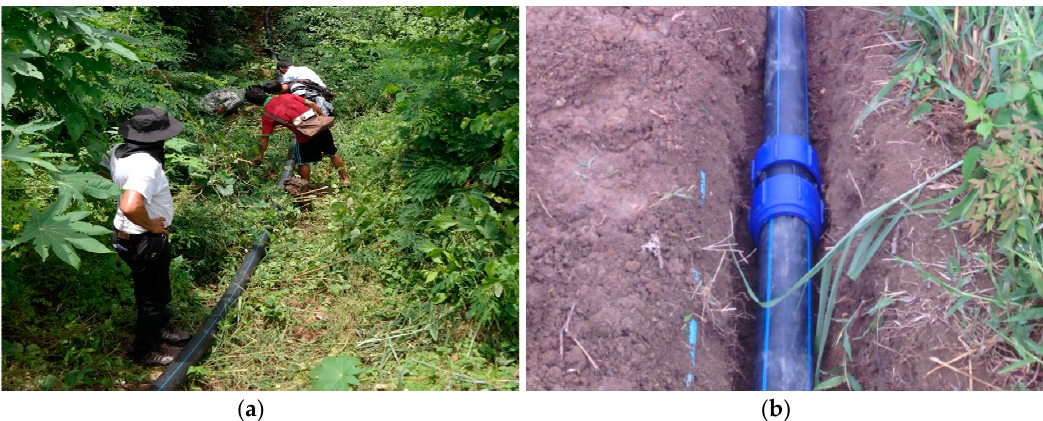
Figure 8. Installation of pipelines ( a ) and coupling system for the high-density polyethylene (HDPE) pipe connection ( b ) (photos by the authors): ( a ) installation of pipeline work; ( b ) coupling system for HDPE pipeline.